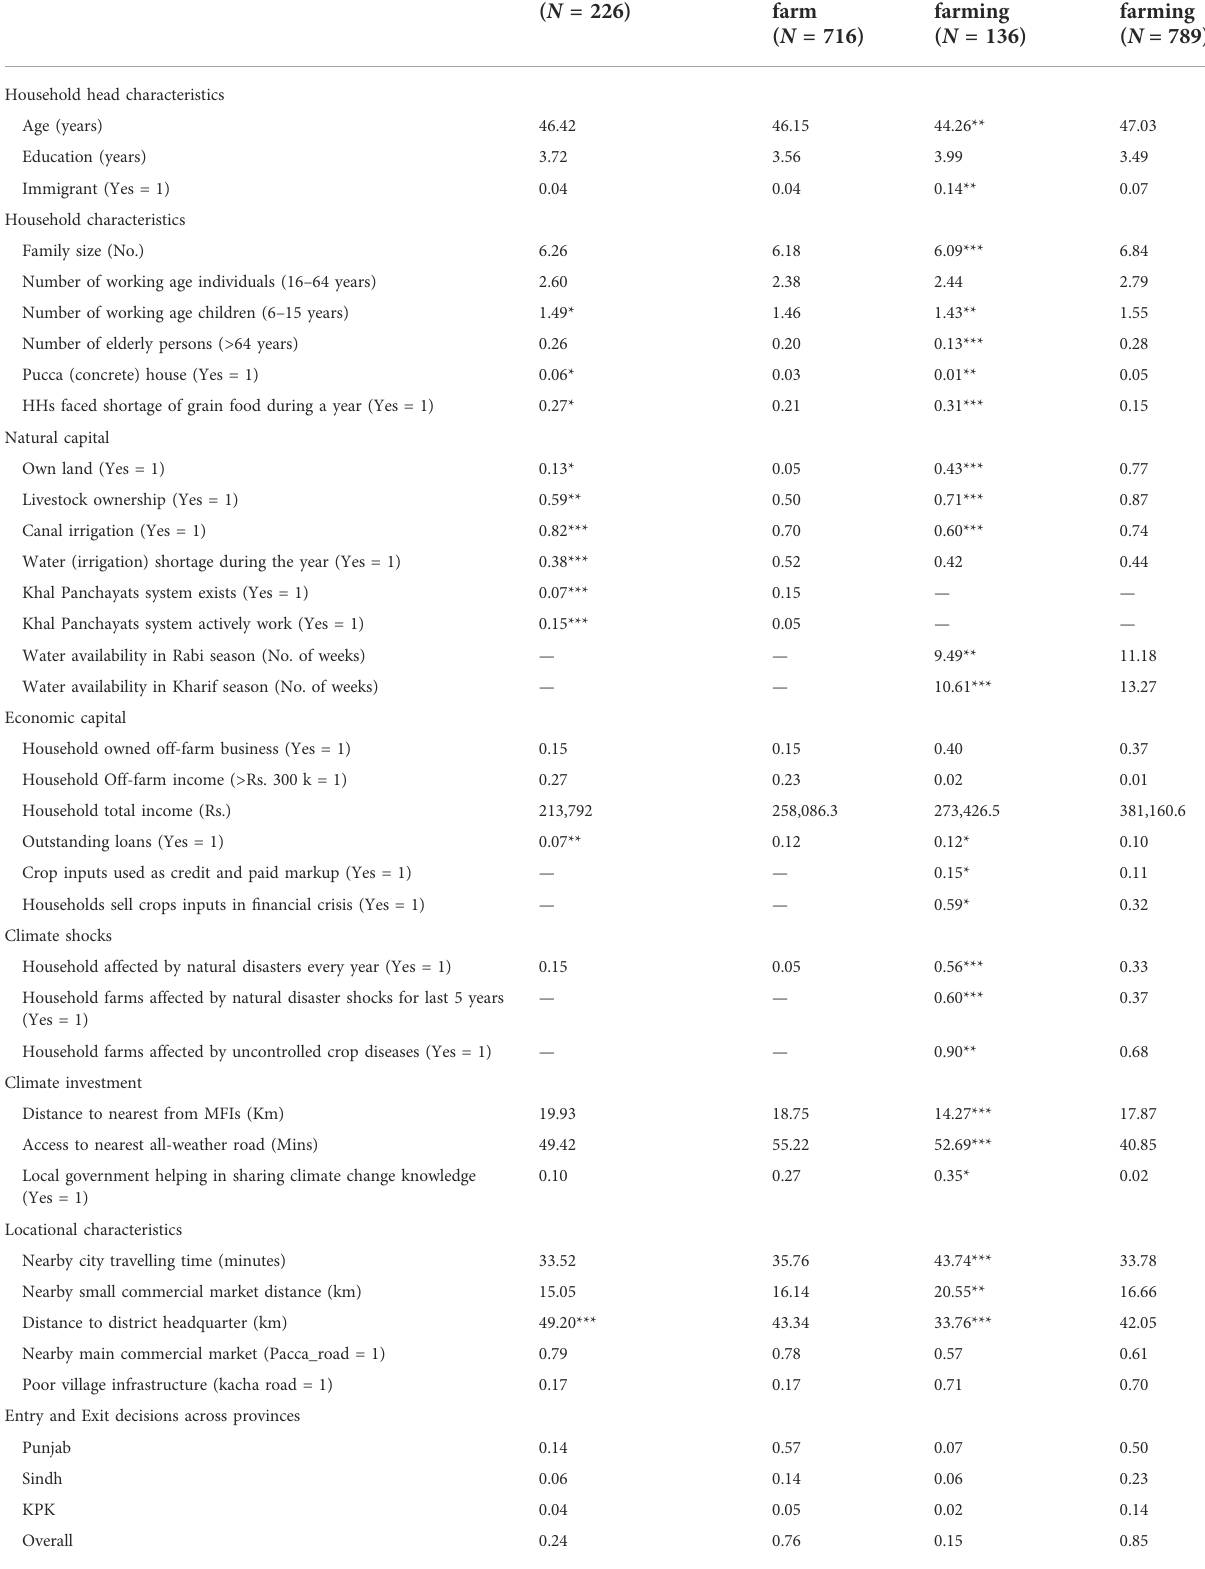
TABLE 2 Descriptive analysis and household characteristics comparison (mean and